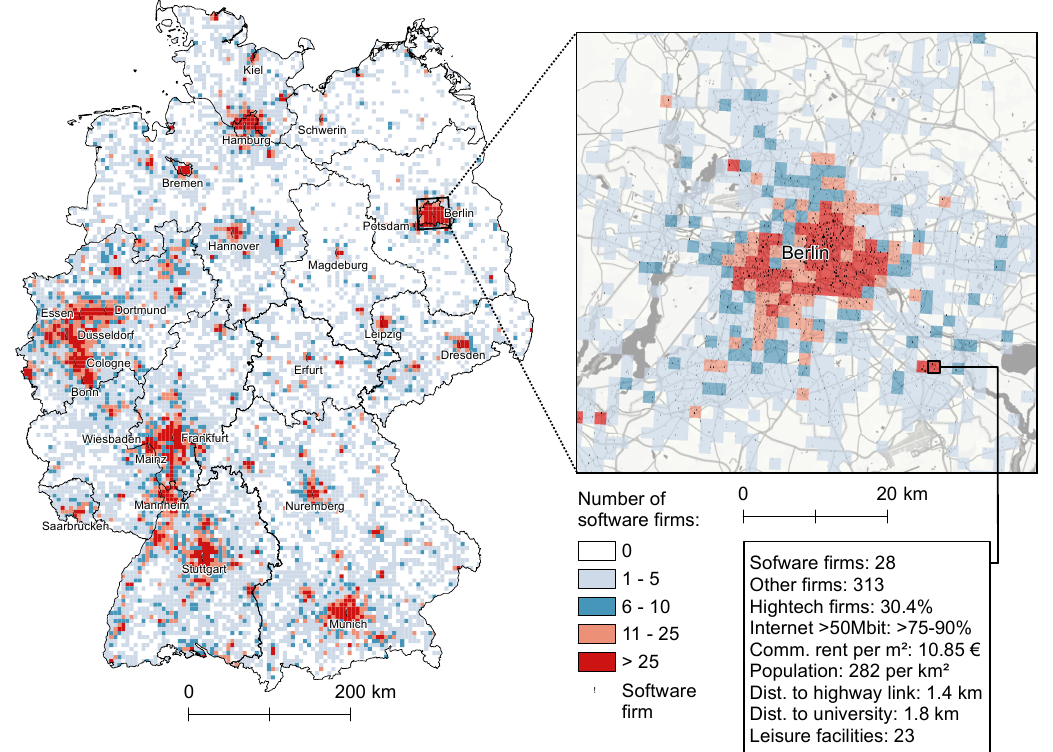
Figure 1. Overview (5 km scale) and zoom (1 km scale; with selection of location factors for exemplary cell) of the software firm location pattern.